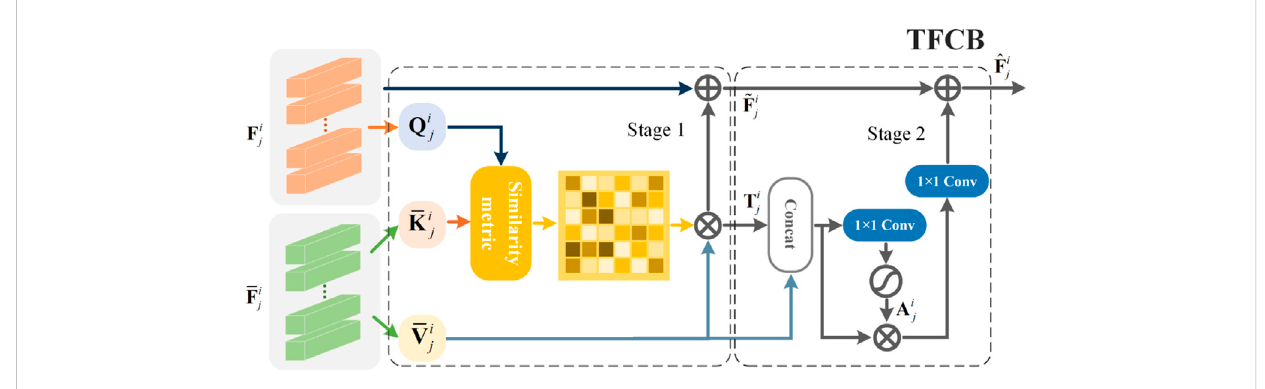
FIGURE 2 Detailed structure of TFCB.